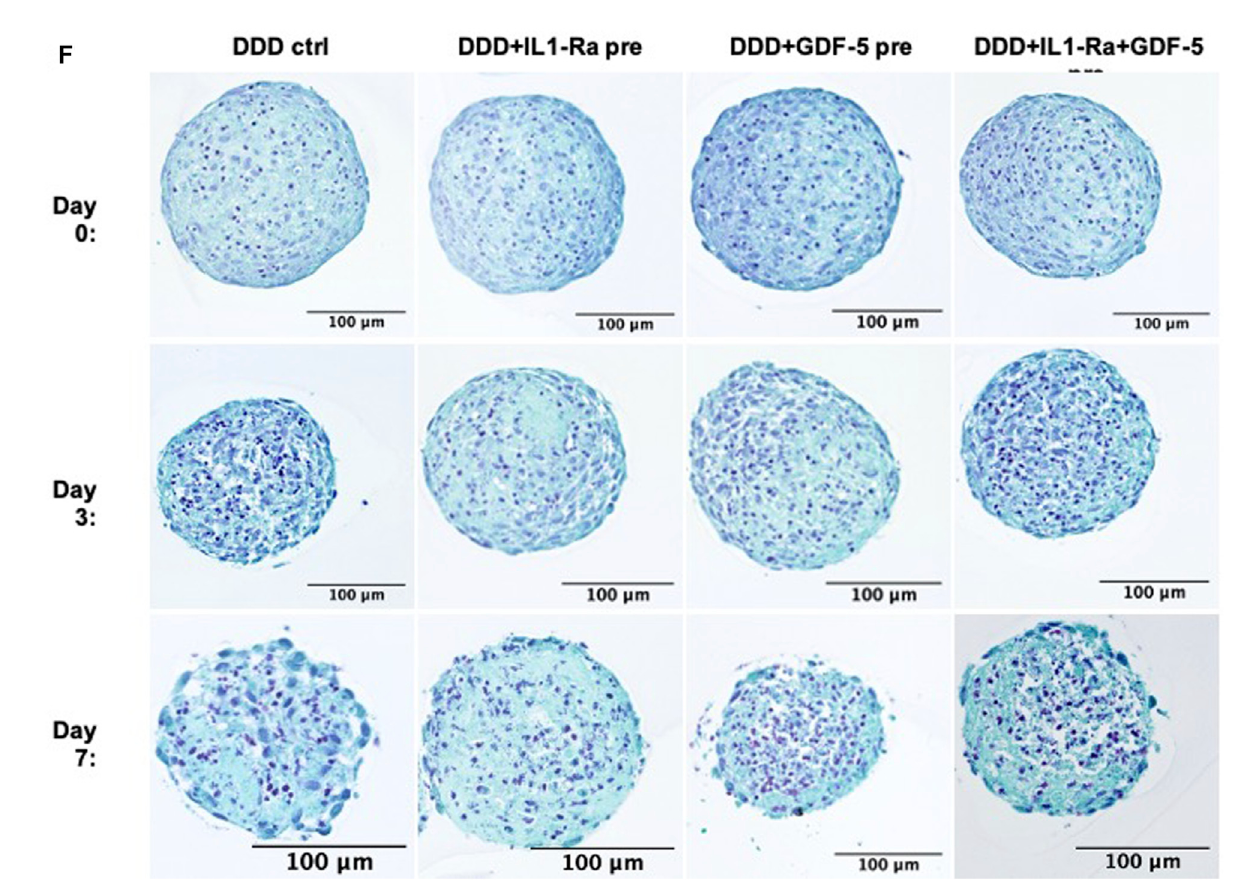
FIGURE 5 The effects of NCS pre-conditioning. Pre-conditioned NCS with IL-1Ra (500 ng/mL), GDF-5 (100 ng/mL) or combined were cultured for 0, 3, 7 days in DDD mimicking conditions and analysed. (A) Relative gene expression (2 -dCt ) of catabolic markers (MMP-3, IL-8). (B) Catabolic shift in NCS was assessed my measuring IL-8 release. (C) Relative gene expression (2 − ΔΔ CT ) of anabolic markers (aggrecan, collagen type I, collagen type II). (D) Glycosaminoglycan (GAG) and hydroxyproline (HYP) content in NCS were quanti fi ed. The (E) The NCS viability was assessed ( n = 3, mean ± SD, *p < 0.05, ANOVA). (F) Histological sections of NCS were stained with